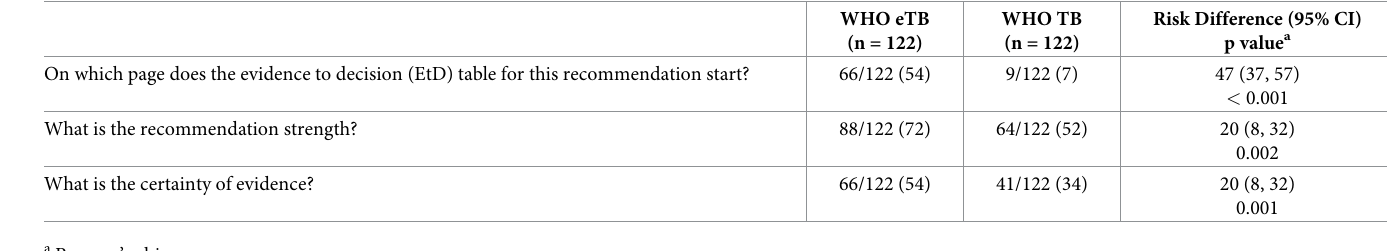
Table 4. Percentage # (%) of participants who responded correctly to understanding